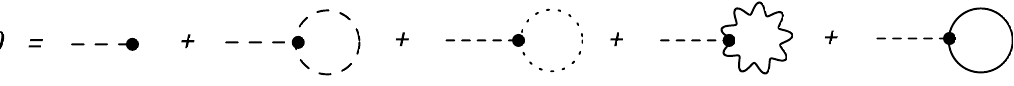
Figure 6 . Diagrammatic illustration of the vanishing of the Higgs tadpole at one-loop order. Solid lines denote top quarks, dashed lines the higgs boson, dotted lines the Goldstone bosons, and wavy lines the gauge bosons. Dots denote SM